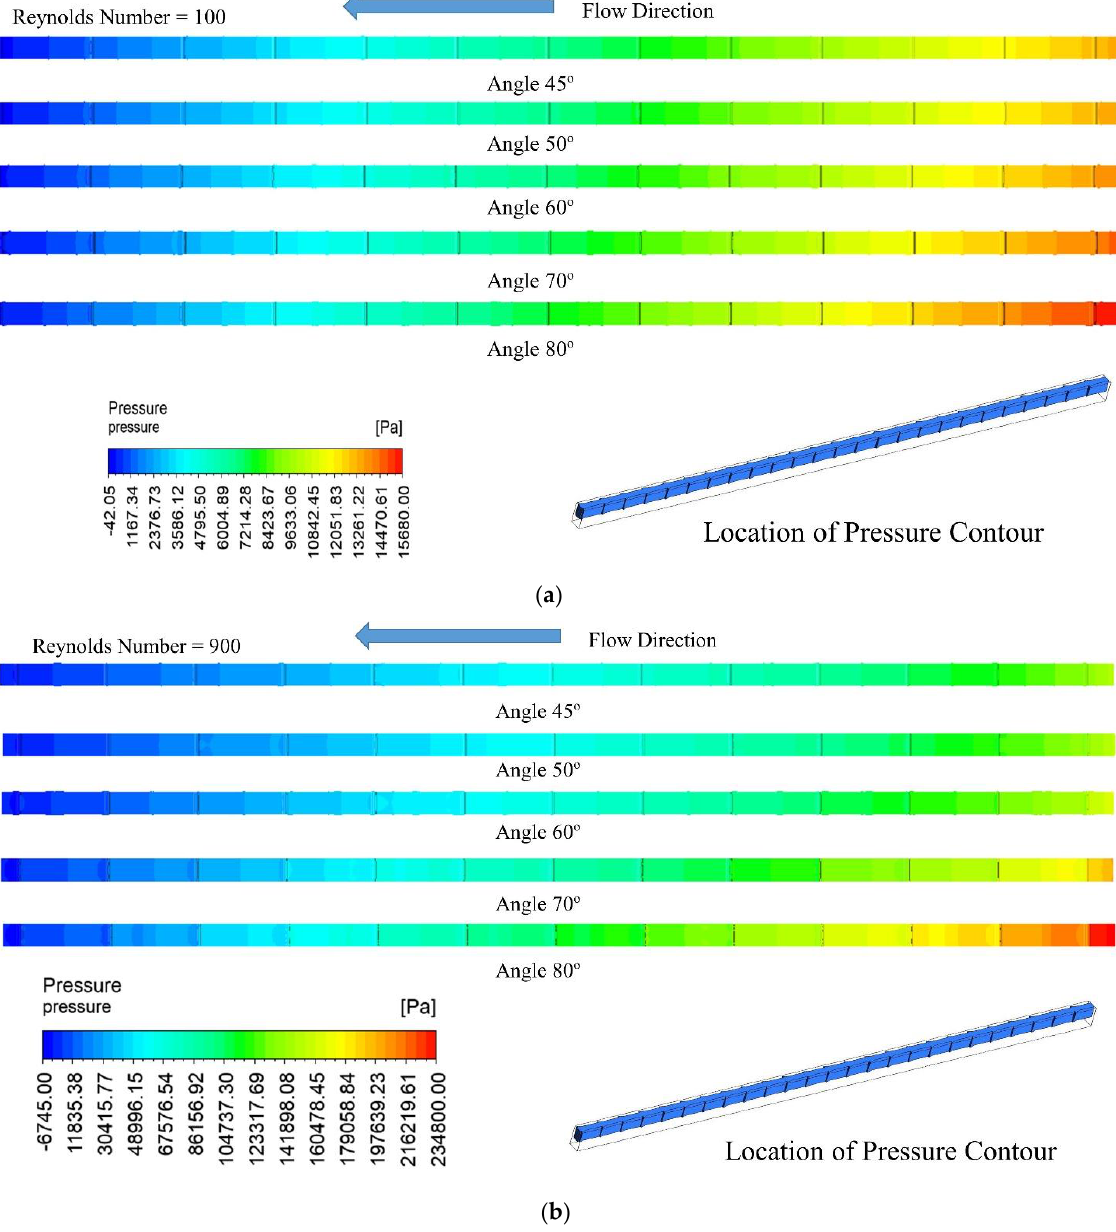
Figure 6. Pressure distribution in the fluid domain at ( a ) Re = 100 and ( b ) Re = 900 .